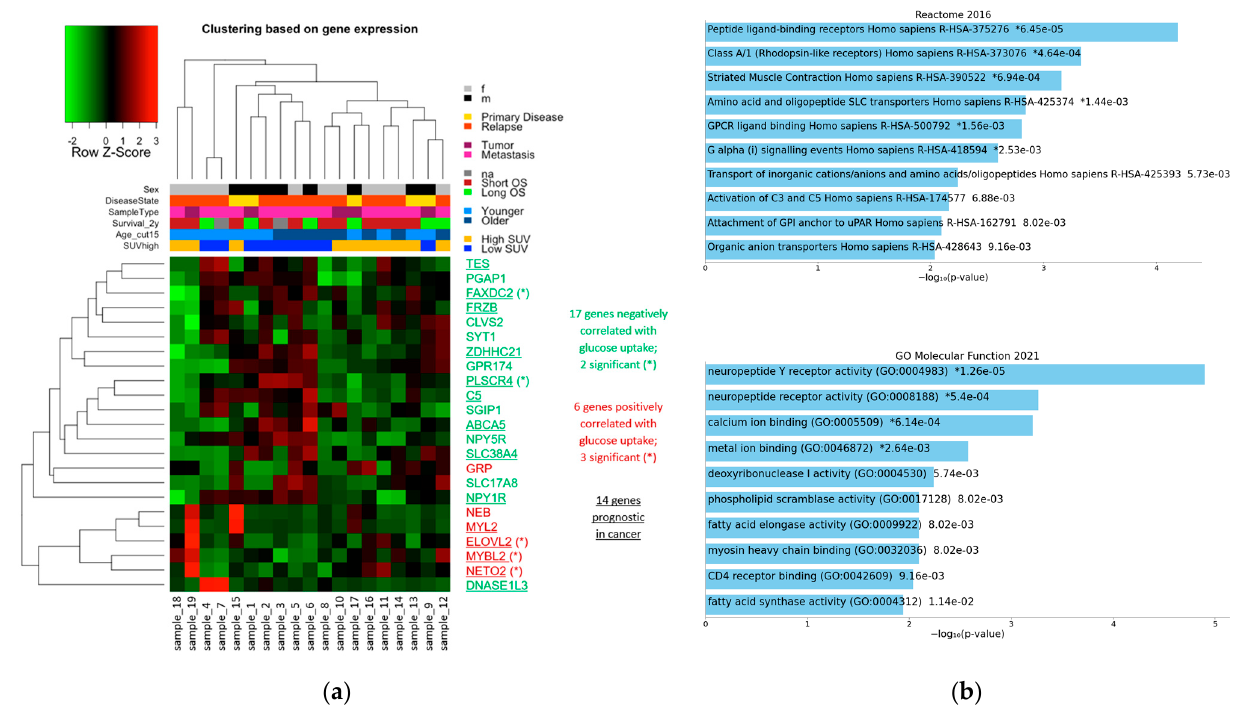
Figure 5: Twenty-three genes with high effect (abs(slope) > 0.146) in linear regression with SUVmax. ( a ) Heatmap depicting their expression in our cohort. On top, clinical data is provided about sex (male or female), disease state (primary disease or relapse), sample type (tumor or metastasis), 2-year OS, age ( ≤ 15 years or >15 years), and categorical partitioning of the samples into high SUV or low SUV (split by median SUVmax). ( b ) Enrichments among the 23 genes with high effect size found by Enrichr (raw p-values are provided). Top: enrichments of the “Reactome Database”. Considering terms with adjusted p -value < 0.01 as significant, one term obtains a significant adjusted p-value (q = 0.0043): “Peptide ligand-binding receptors Homo sapiens R-HAS-375276”. Bottom: enrichments of “GO molecular function”. One term obtains a significant adjusted p-value (q = 0.0007): “neuropeptide Y receptor activity (GO:0004983)”.